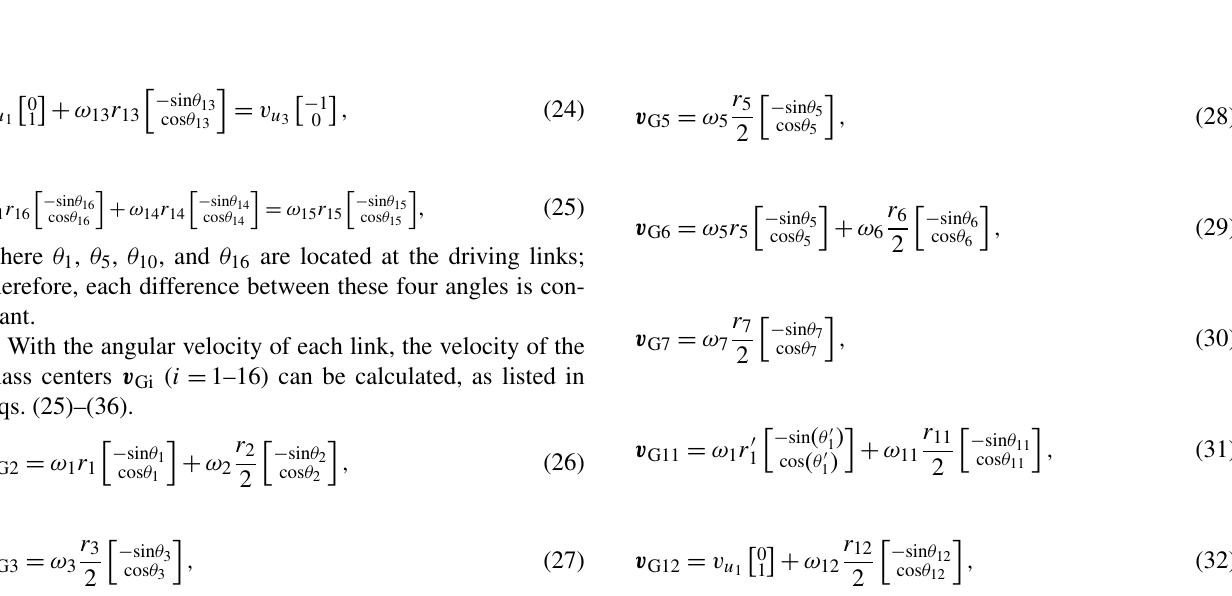
Figure 10. Vectors for driving force